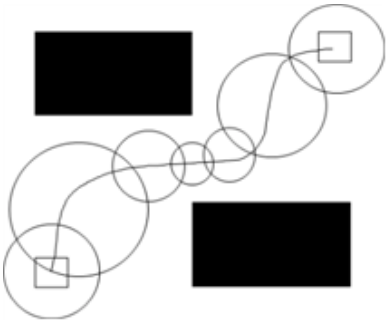
Figure 6. Bubbles formed along the created path.